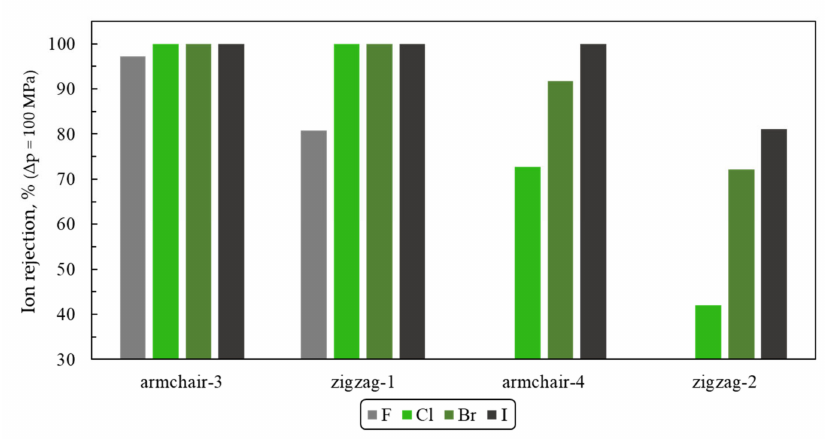
Figure 7. Halide-ions rejection at pressure drop ∆ p = 100 MPa (a rejection rate of Armchair-4 and Zigzag-2 membranes for fluorine anions F – was not